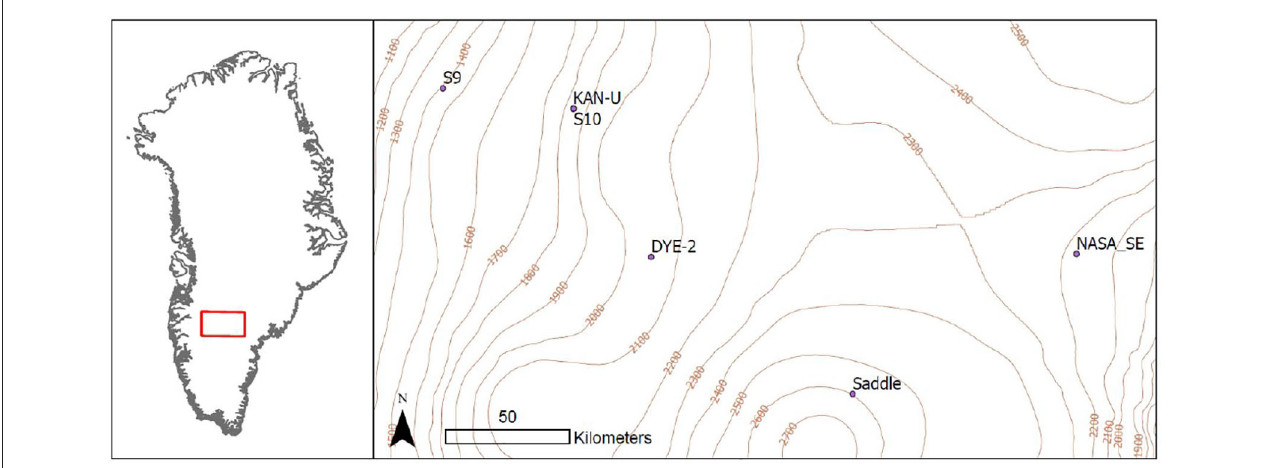
FIGURE 1 | Map of study area and the site locations of the six automatic weather stations used in this study. The red box represents the study area in view. KAN_U and Site 10 are only 30 m apart from one another.